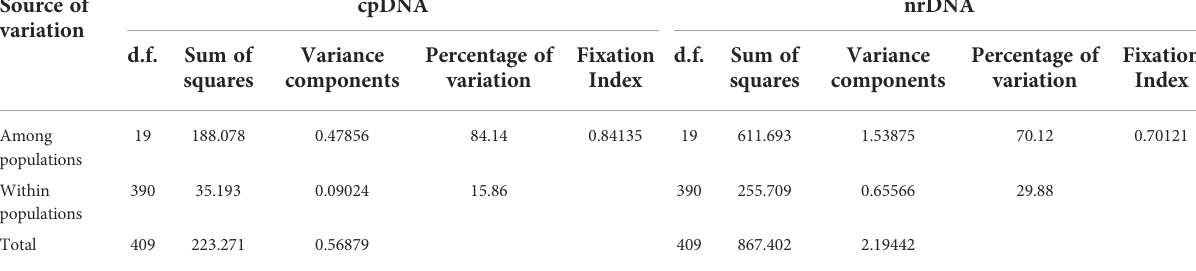
TABLE 4 AMOVA analysis based on the cpDNA and nrDNA for Ch. utilis